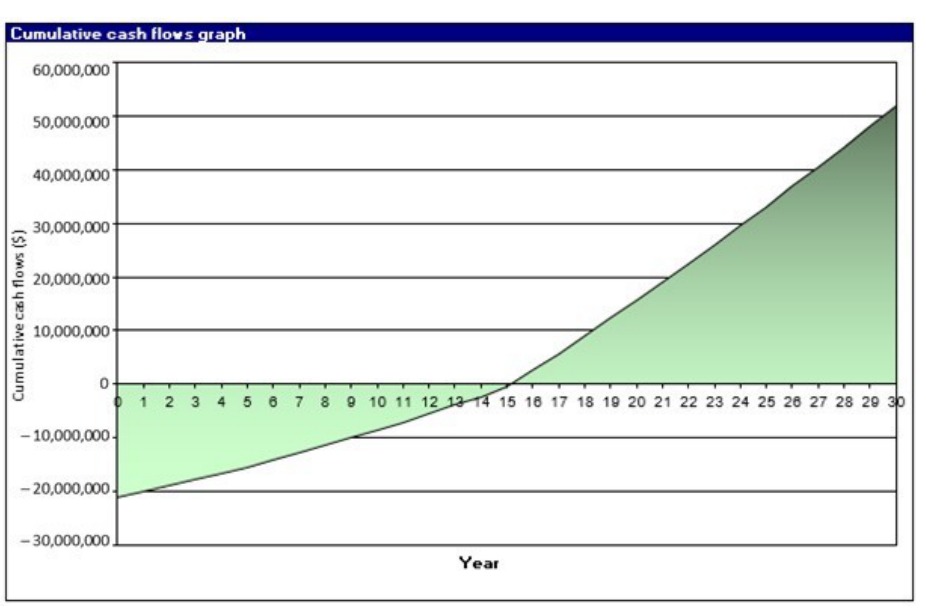
Figure 7. Return on investment, and long-term cash-flow, for Scenario 2. For scenario 2, the LCOE obtained is 0.26 USD/kWh, which remains competitive concerning diesel production and makes installing an OTEC facility with desalination economically viable at San Andrés